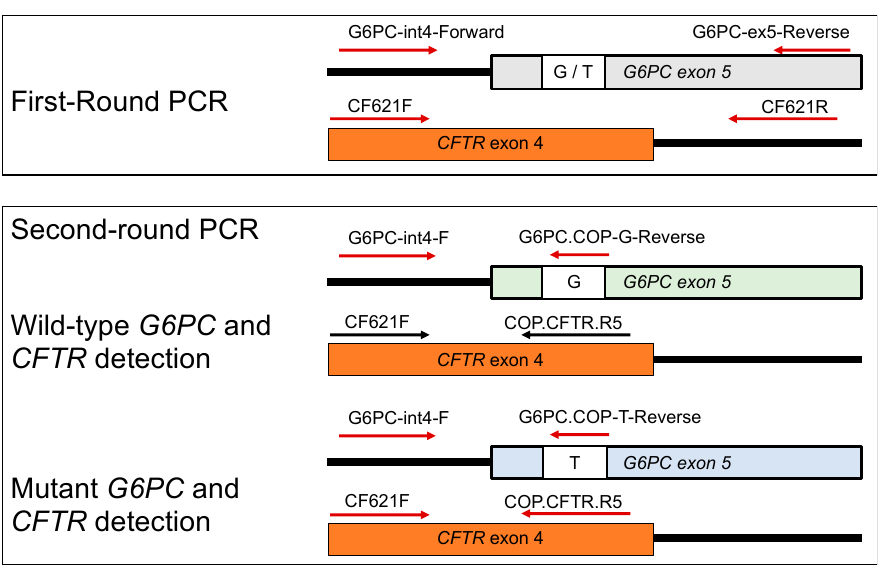
Figure 1. Primer locations of the G6PC and CFTR genes used in this study. The first-round PCR primers were non-allele-specific. The second-round PCR reverse primers were COP primers, and the reverse G6PC primers were allele-specific to either the wild-type allele, G, or the mutant allele, T. Arrows indicate the direction of the primer.